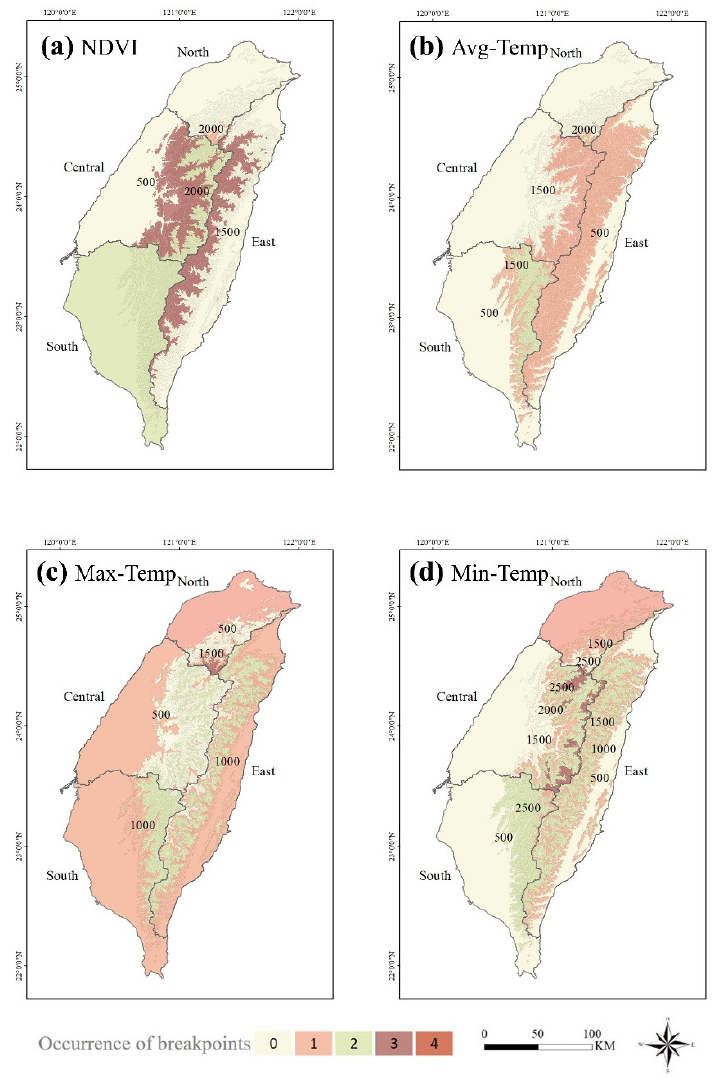
Figure 6. Occurrence of breakpoints for the ( a ) NDVI, ( b ) average temperature, ( c ) maximum tem- perature, and ( d ) minimum temperature.